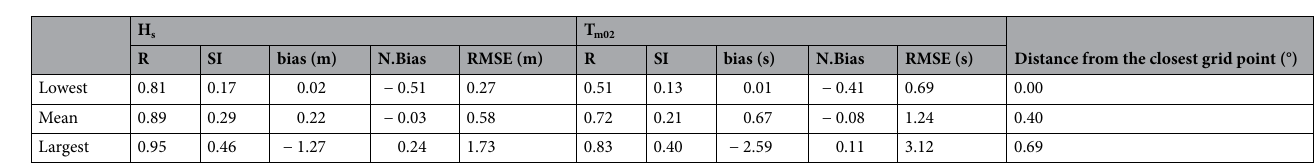
Table 1. Summary of error statistics in the estimated H s and mean periods determined for 64 buoy